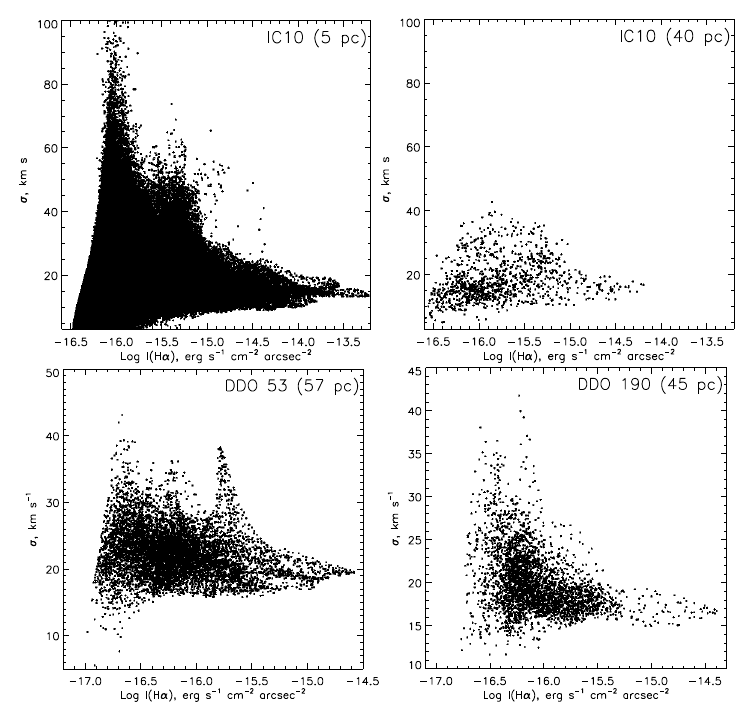
Fig. 1. The I H (cid:11) (cid:0) (cid:27) diagram for nearby dwarf galaxies according to Moiseev & Lozinskaya (2012): IC 10 (original and smoothed data), DDO 53 and DDO 190. The spatial resolution is indicated in the